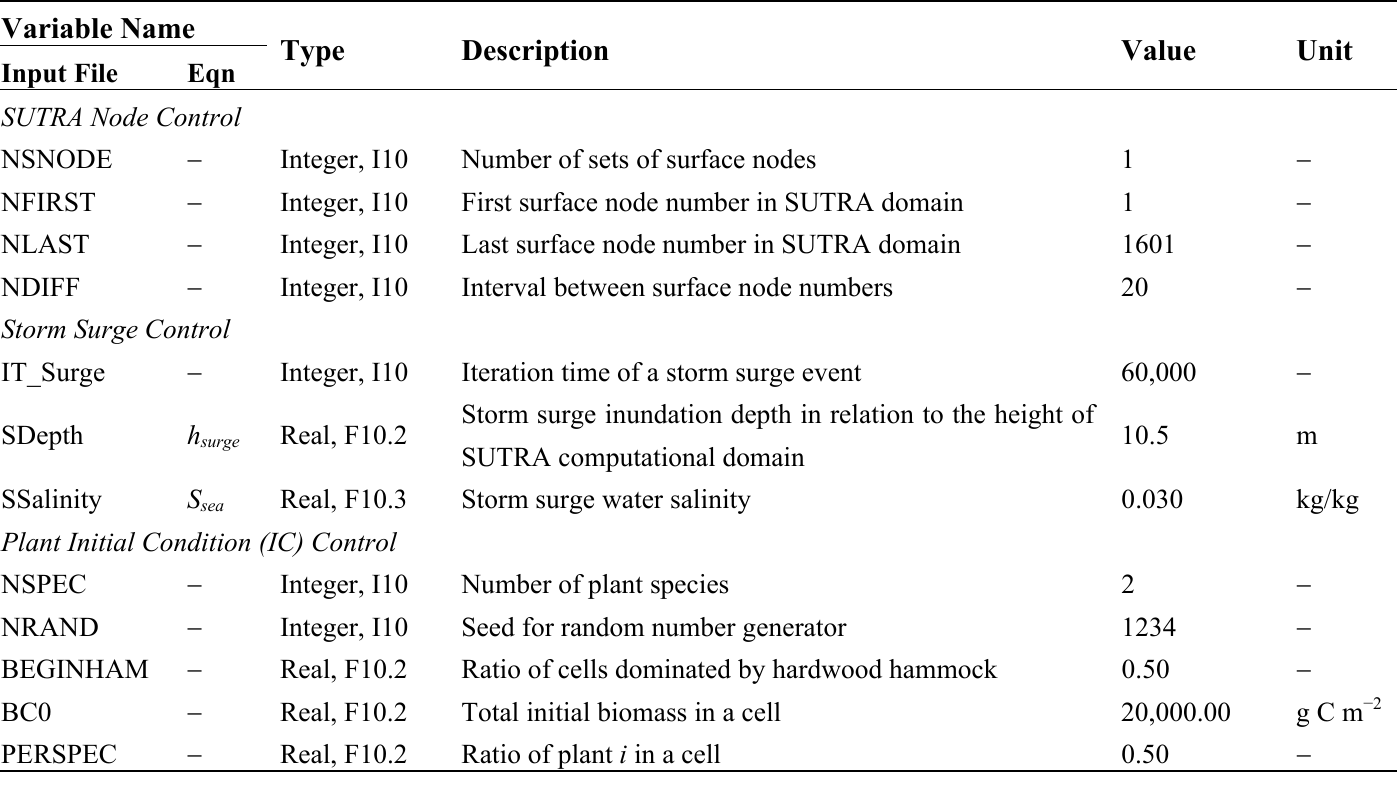
Table A2.2. List of parameters in MANHAM.DAT with their description, type, value and